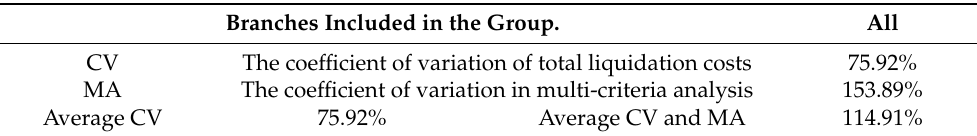
Table 3. The analysis of the branches of SRK S.A. as a one group. Branches Included in the Group.